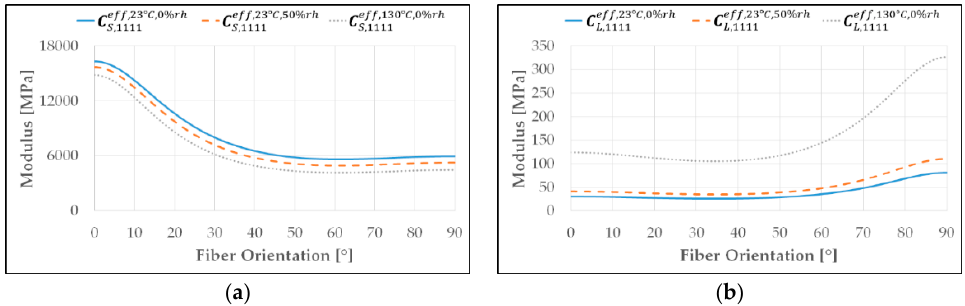
Figure 10. Components of the fourth ranked ( a ) stiffness and ( b ) damping tensors of PA66 ‐ GF30 at 23 °C and 0% rh, 23 °C and 50% rh, 130 °C and 0% rh.